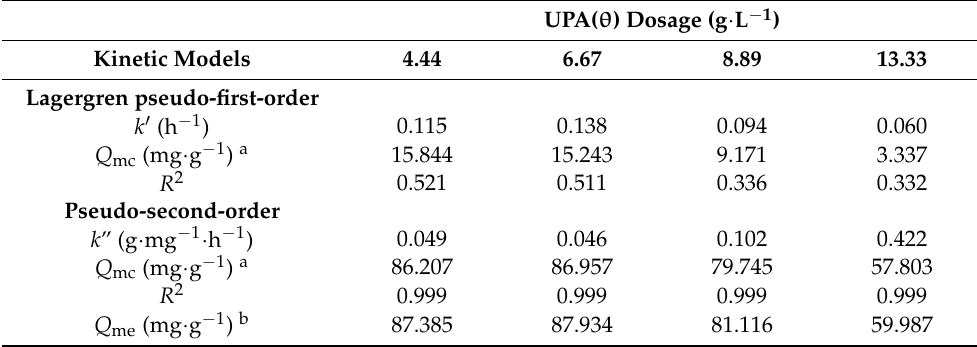
Figure 4. Tests of the ( a ) Lagergren pseudo-first-order, ( b ) pseudo-second-order, ( c ) film diffusion (Boyd plot), and ( d ) intraparticle diffusion (Weber and Morris plot) models on RBBR adsorption retained by UPA( θ ) powders. Table 1. Parameters of RBBR adsorption kinetics fitted by the Lagergren pseudo-first-order and pseudo-second-order models at T = 310 K.